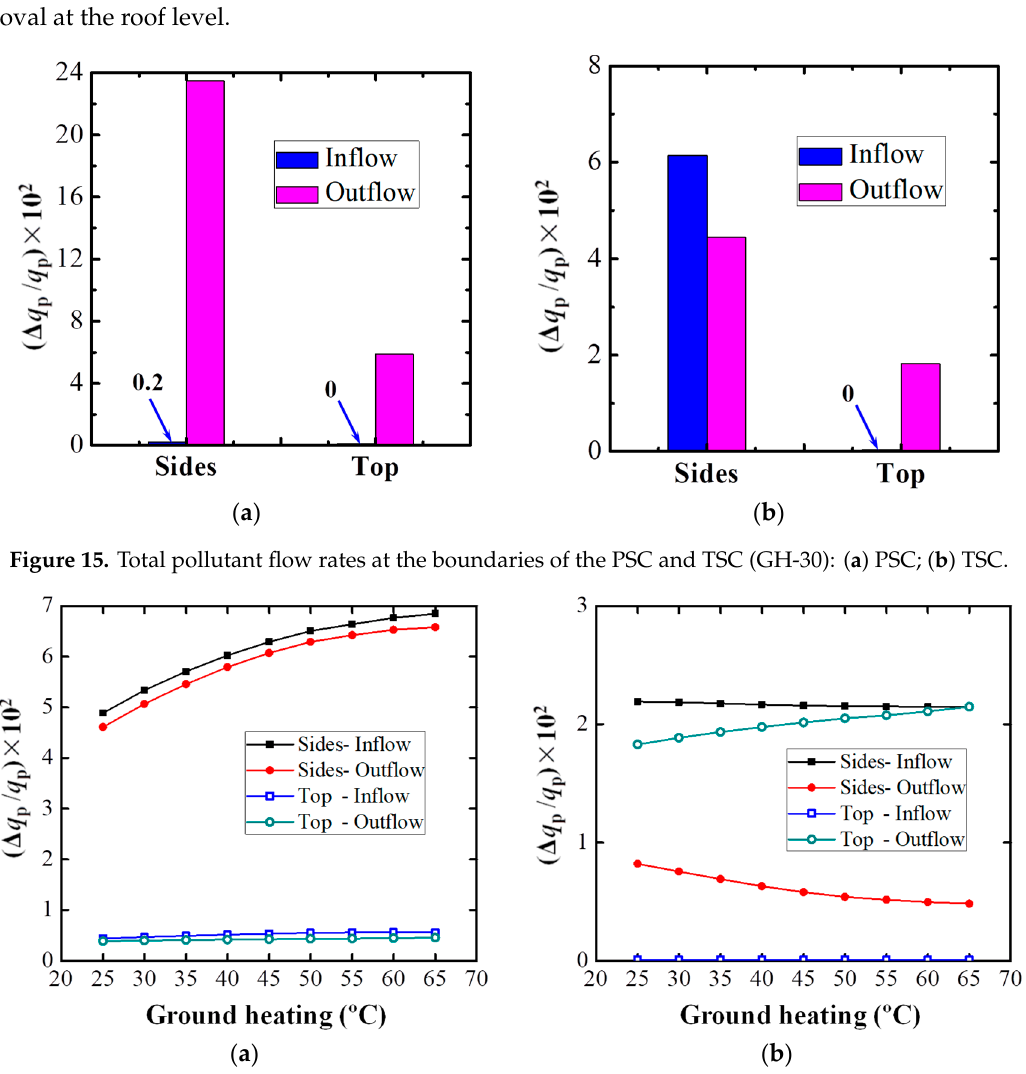
Figure 15. Total pollutant flow rates at the boundaries of the PSC and TSC (GH-30): ( a ) PSC; ( b ) TSC.